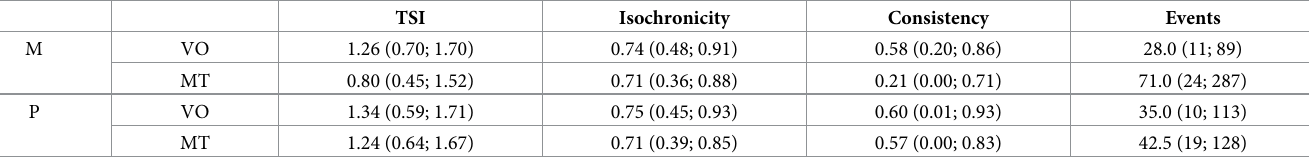
Table 2. Parameters of systematics obtained from video observation (VO) and motion tracking (MT) for manual (M) and powered (P) toothbrushing, first part of the study